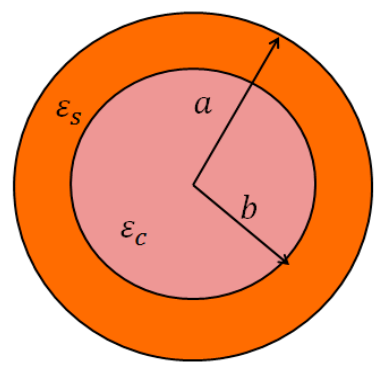
Figure 3. The model of the nanoparticle Fe 3 O 4 @Au core-shell.